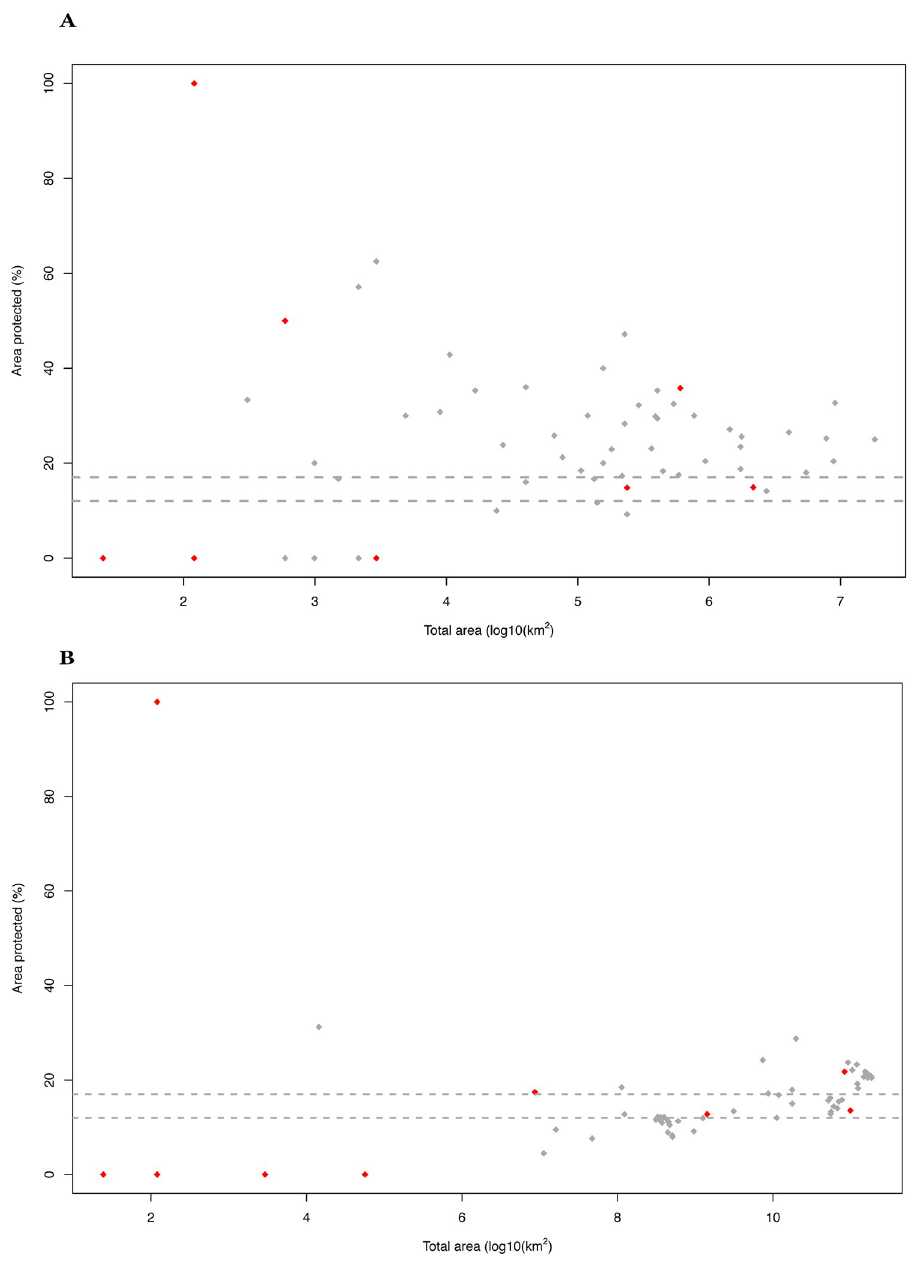
Fig 9. Percentage of the species’ distribution area included within a protected area. Dashed lines indicate the Aichi biodiversity conservation targets of 17% and 12%. A) Results of the analysis using the area of occupancy (AOO) taking into account all the observed records at a resolution of 2x2 km (4 km 2 ); B) results of the analysis using the species potential distribution (SPD), calculated by the sum of all 4 km 2 cells inside the potential distribution of each species inferred with species distribution models (SDMs). For the species for which it was not possible to infer SDMs (see Results), the area used for the analysis was that comprised within the minimum convex polygon of their occurrence point data. Red dots indicate the threatened taxa. Only the 57 native species have been included in the analyses.